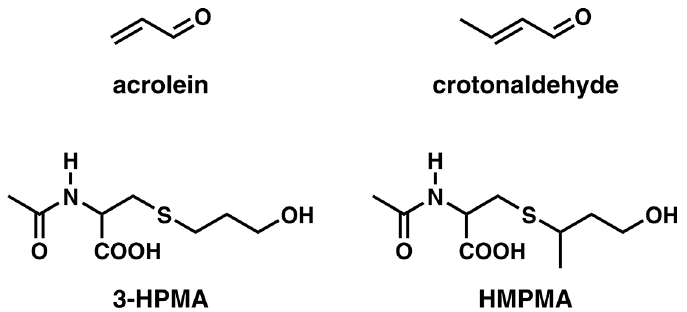
Fig 1. Structures of acrolein, crotonaldehyde, 3-HPMA, and